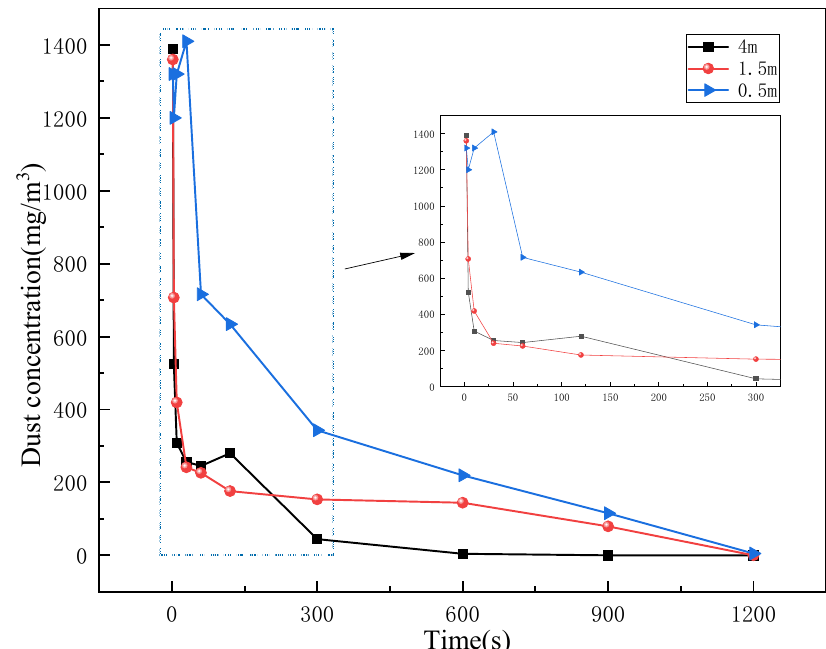
Figure 6. Curves of the blasting dust concentration with time at three height levels.